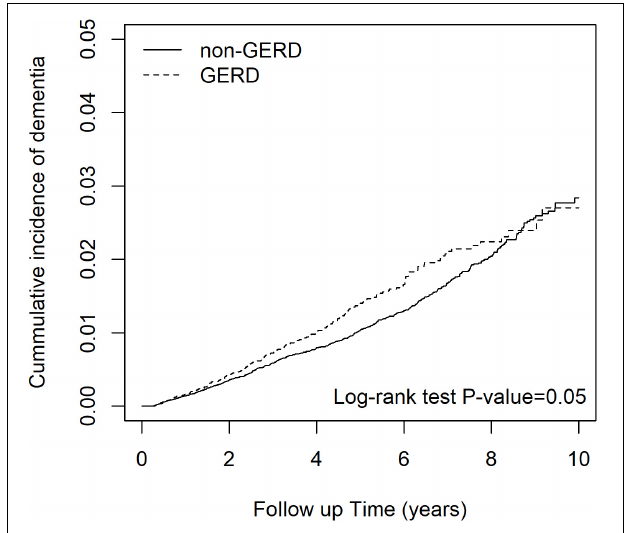
FIGURE 2 | The cumulative incidence curves of patients with and without